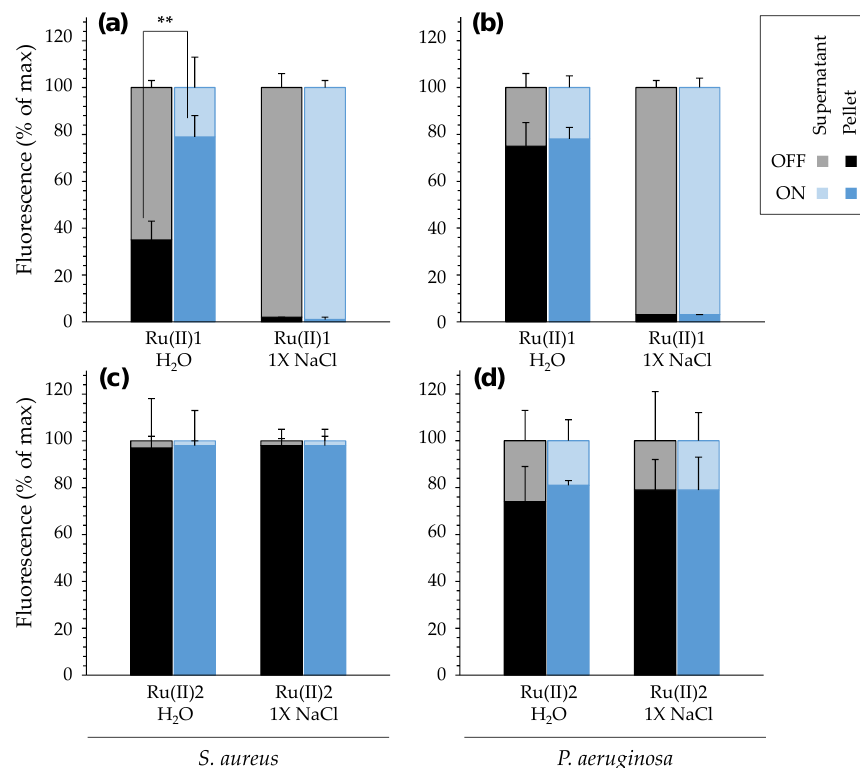
Figure 5. Interaction assay between [Ru(II)] and bacteria when mixed either in water or in 1X NaCl. Results were obtained using [Ru(II)]1 ( a , b ) or [Ru(II)]2 ( c , d ) with S. aureus RN4220 ( a , c ) and P. aeruginosa PA19660 ( b , d ). See Figure S4 for results obtained with other bacterial strains. [Ru(II)] = 25 µM. Mean SD with n = 3 and N ≥ 2. **, p - value ≤ 0.01.